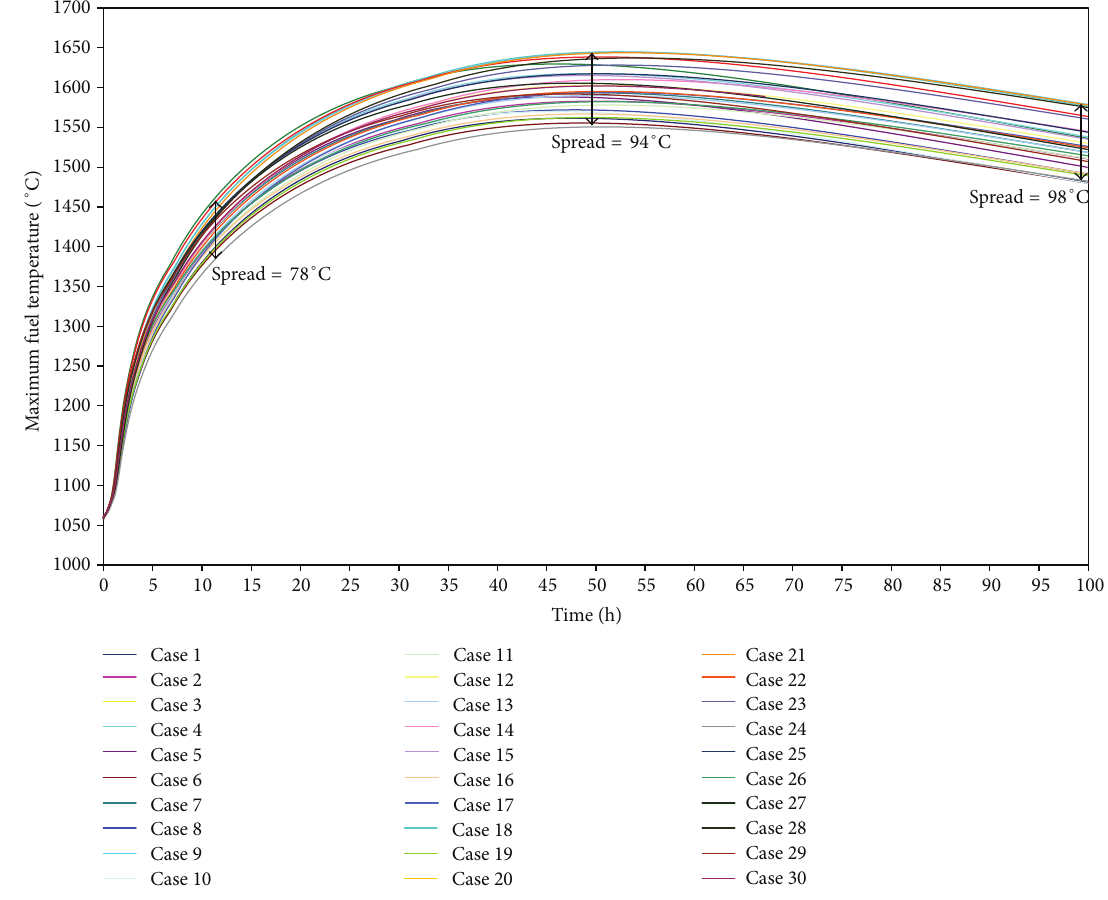
F 6: DL�F� maximum fuel temperature versus time for the �rst 30 cases of the 200 LHS Normal set.